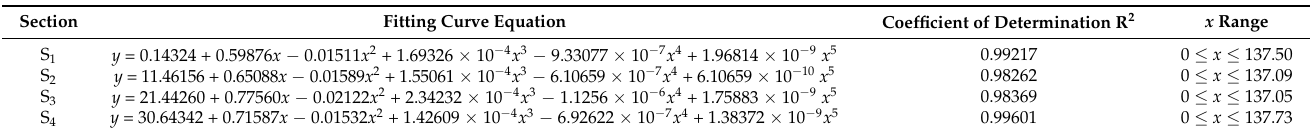
Figure 3. Fitting Curve Equation image. Figure 3. Fitting curve equation image. Figure 3. Fitting curve equation image. Table 1. Fitting curve Table 1. Fitting curve equation. Table 1. Fitting curve equation.